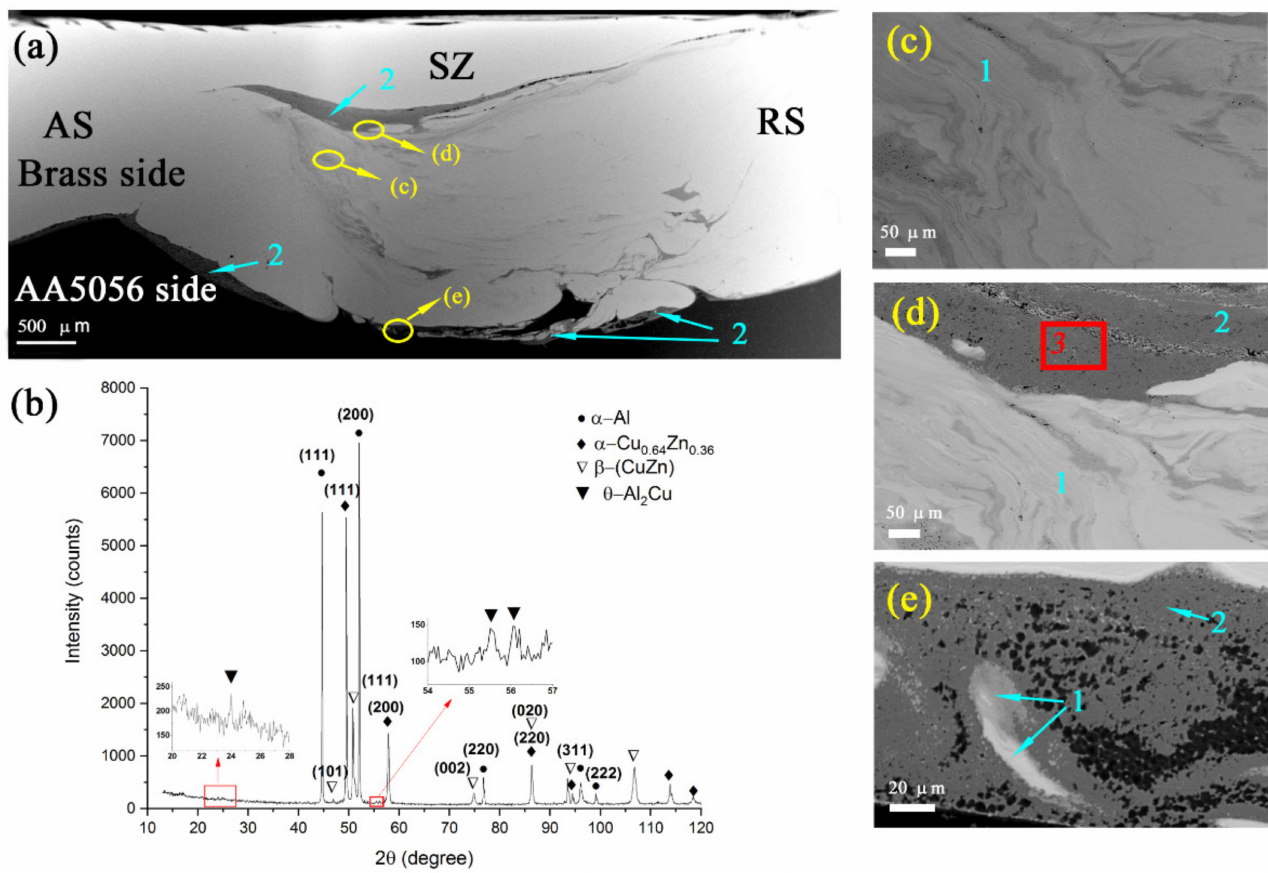
Figure 5. SEM BSE image of AA5056/CuZn37 SZ ( a ), XRD diffractogram ( b ), and enlarged fragments of SZ showing its inhomogeneity ( c – e ). 1—region of solid solution, 2—region of IMCs, 3—region where TEM studies were